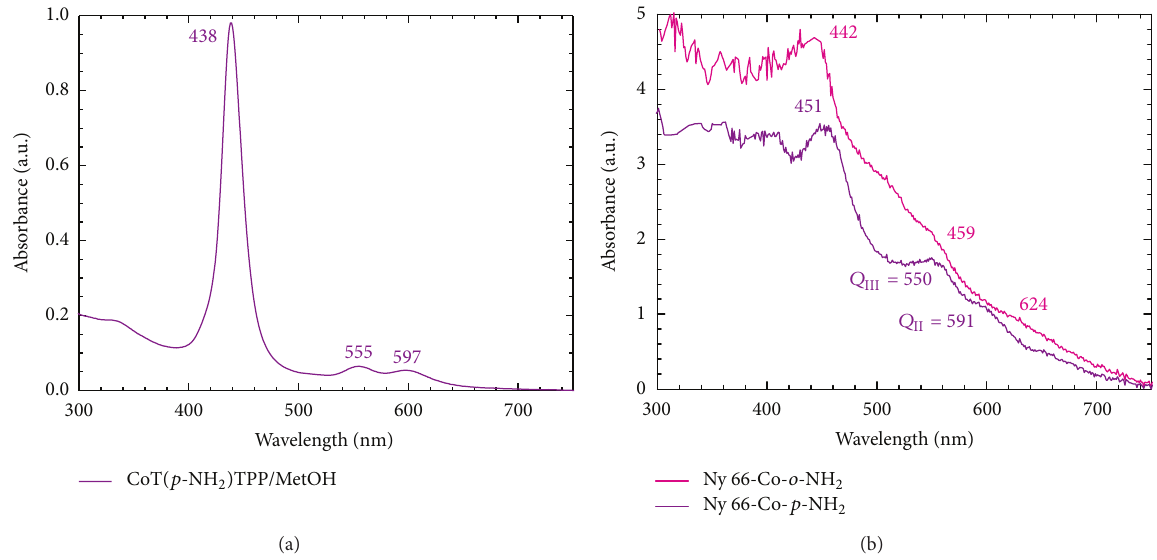
Figure 12: (a) UV-Vis spectra of CoT( p -NH 2 )PP in solution and of the (b) Ny 66-Co- o -NH 2 and Ny 66-Co- p -NH 2 polymers.